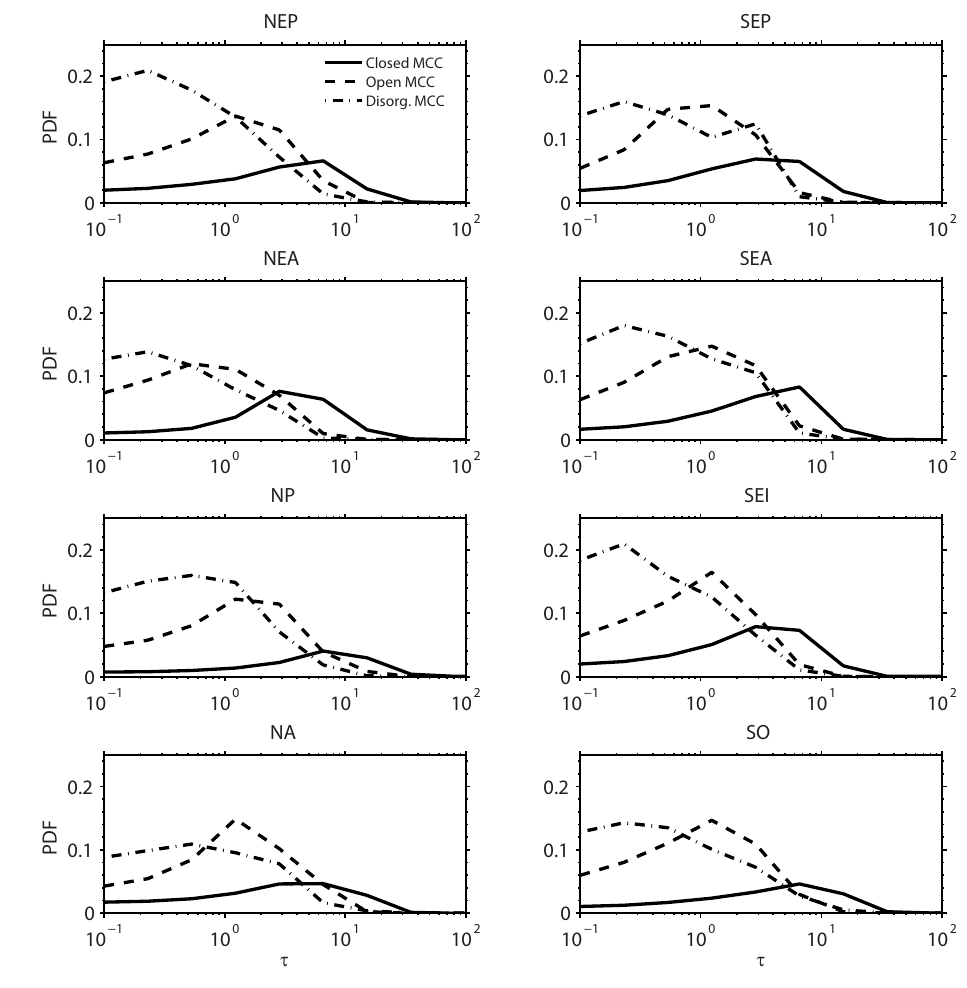
Figure 14. Same as Fig. 12 but for cloud optical depth ( τ